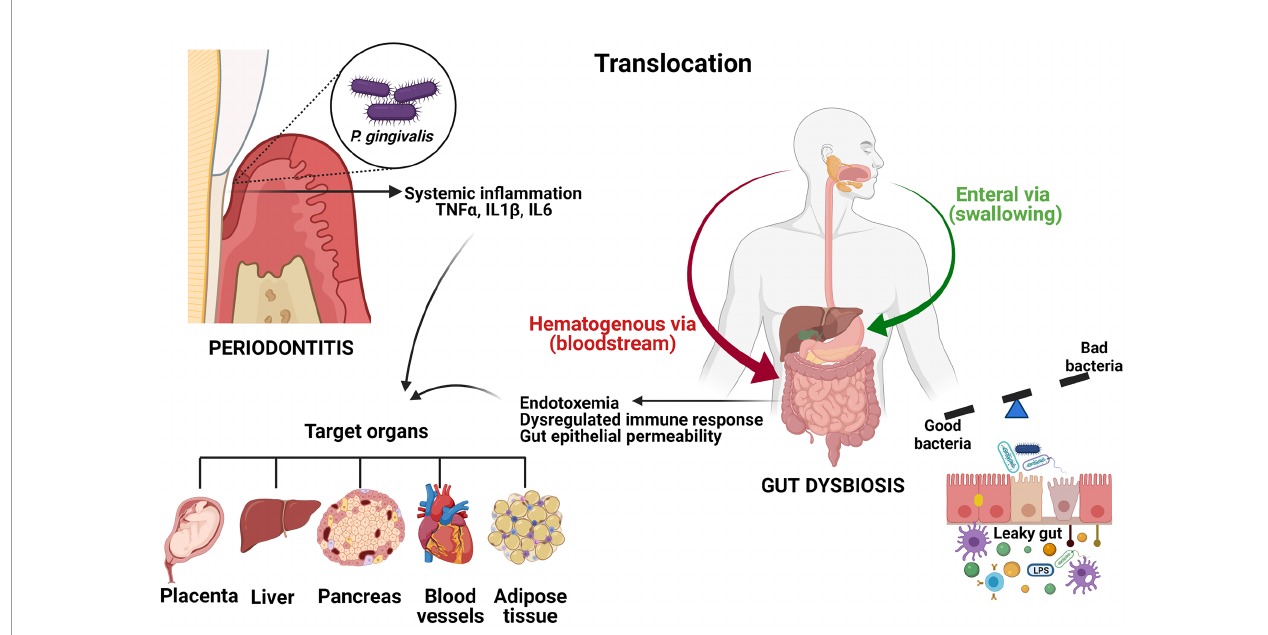
FIGURE 4 | Oral and GI systemic connections. Oral bacteria can translocate to the digestive tract enterally or parenterally. In periodontitis, locally pro-in fl ammatory mediators including TNF a , IL1 b and IL6 can enter the systemic circulation and induce a low-grade systemic in fl ammation. Disruption of the gut epithelial barrier induced by dysbiosis results in increased gut epithelial permeability, thus creating a leaky gut. This leakage generates endotoxemia, systemic in fl ammation and a dysregulated immune response. Since some diseases such as type 2 diabetes, non-alcoholic fatty liver disease, obesity and atherosclerosis have been associated with periodontitis, as well as with gut dysbiosis, it is reasonable to assume that swallowing oral bacteria via saliva could represent a possible mechanism linking periodontitis and systemic diseases.The fi gures were created with